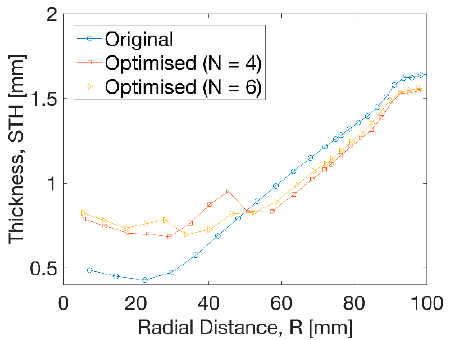
Figure 9. Thickness distribution at different processing conditions.